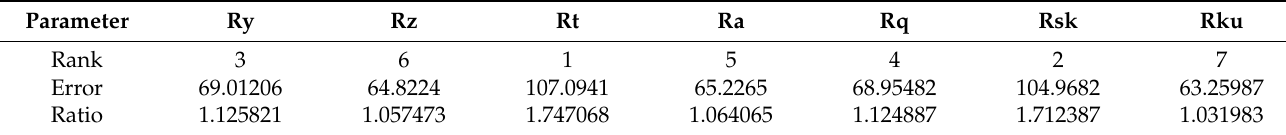
Table 9. Results of the sensitivity analysis for the network 7:7–7-1:1